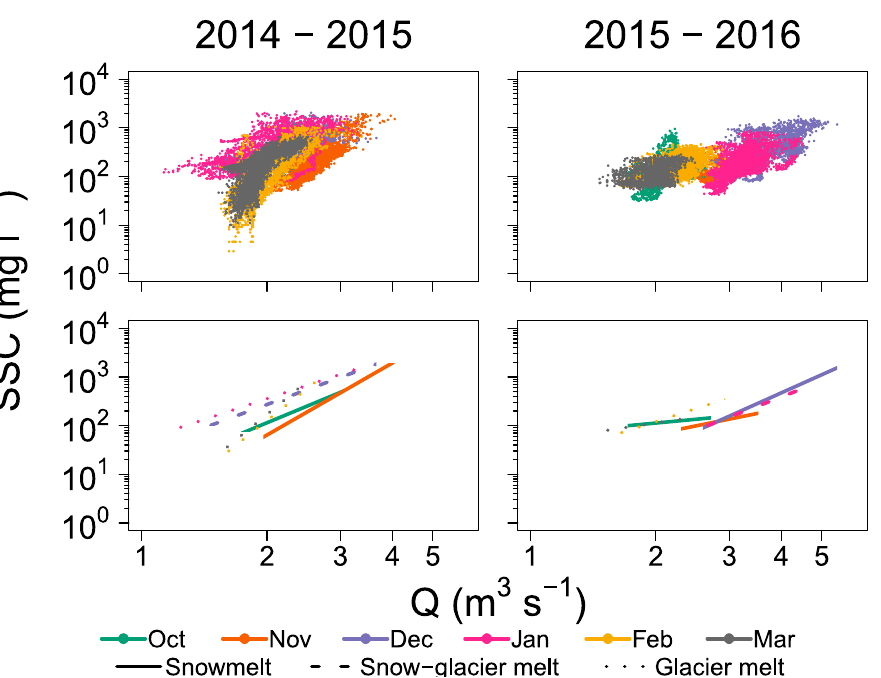
Figure 7. Water discharge (Q) and suspended sediment concentration (SSC) relationship grouped by month in the two ablation seasons at MS-D in the Estero Morales basin. The plots show the data points (above) and the regressions calculated by splitting the data series per month.